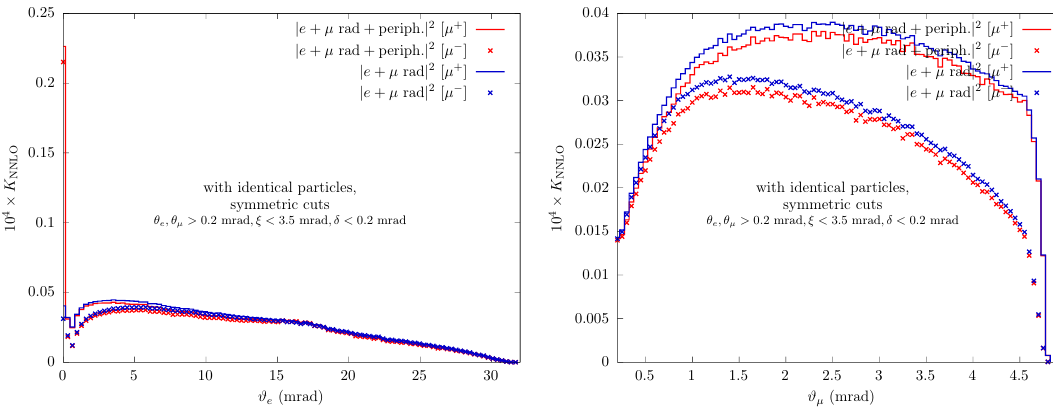
Figure 23. Differential K NNLO factor for θ e (left) and θ µ (right) distributions for real e + e − radiation with realistic event selection, with all cuts applied.